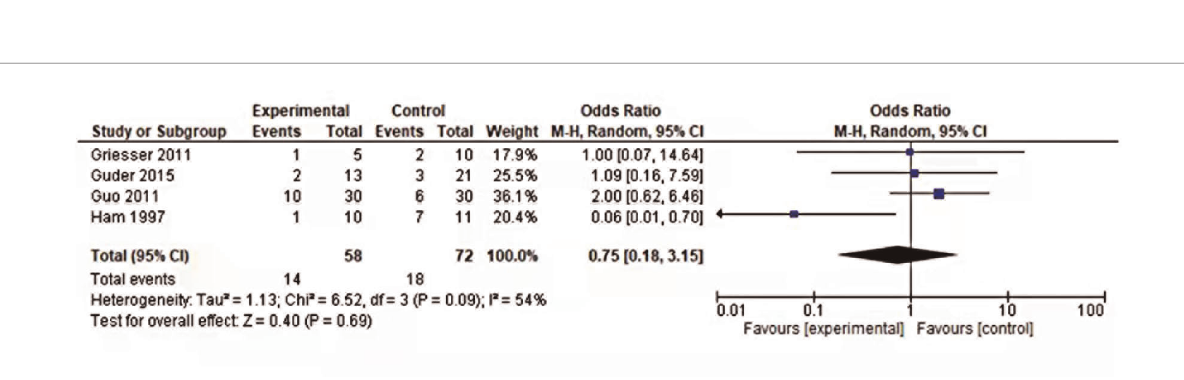
FIGURE 2 ( A ) Forest plot of comparison 5-year survival rate of internal vs. external hemipelvectomy in pelvic tumors. ( B ) Forest plot comparing local recurrence of internal vs. external hemipelvectomy in pelvic tumors.